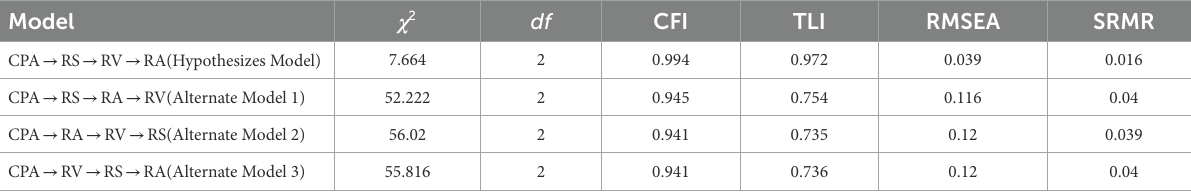
TABLE 5 The model fit comparisons between hypothetical theoretical model and alternative model. Model